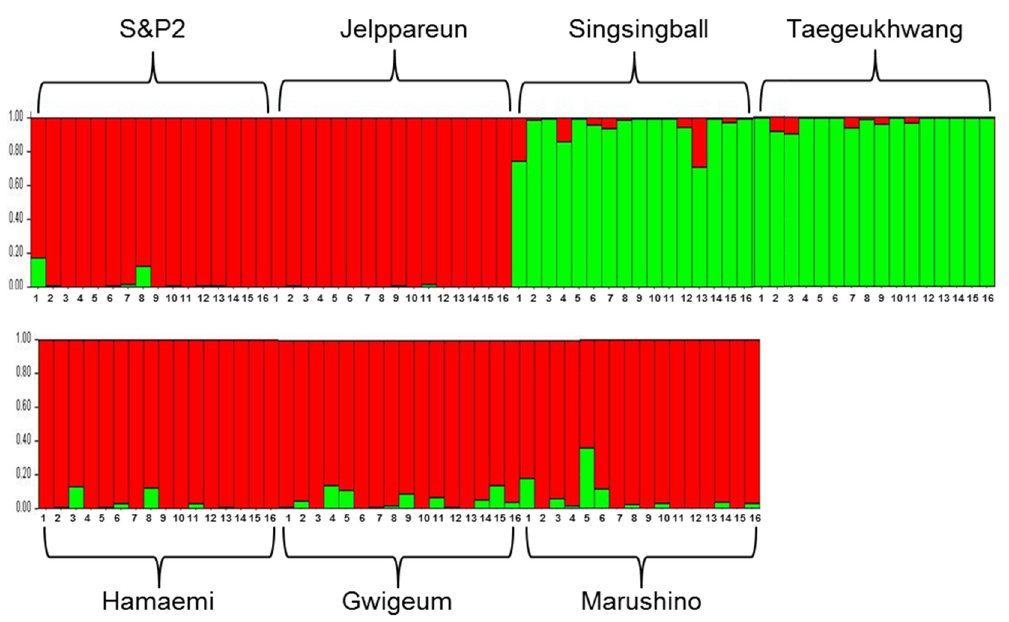
Figure 3. Inferred clusters in the onion varieties using the STRUCTURE software, where K is the potential number of genetic clusters that may exist in the overall sample of individuals. Each vertical line represents one individual multilocus genotype. Individuals with multiple colors have mixed genotypes from multiple clusters. Each color represents the most likely ancestry of the cluster from which the genotype or partial genotype was derived. Clusters of individuals are represented by colors.